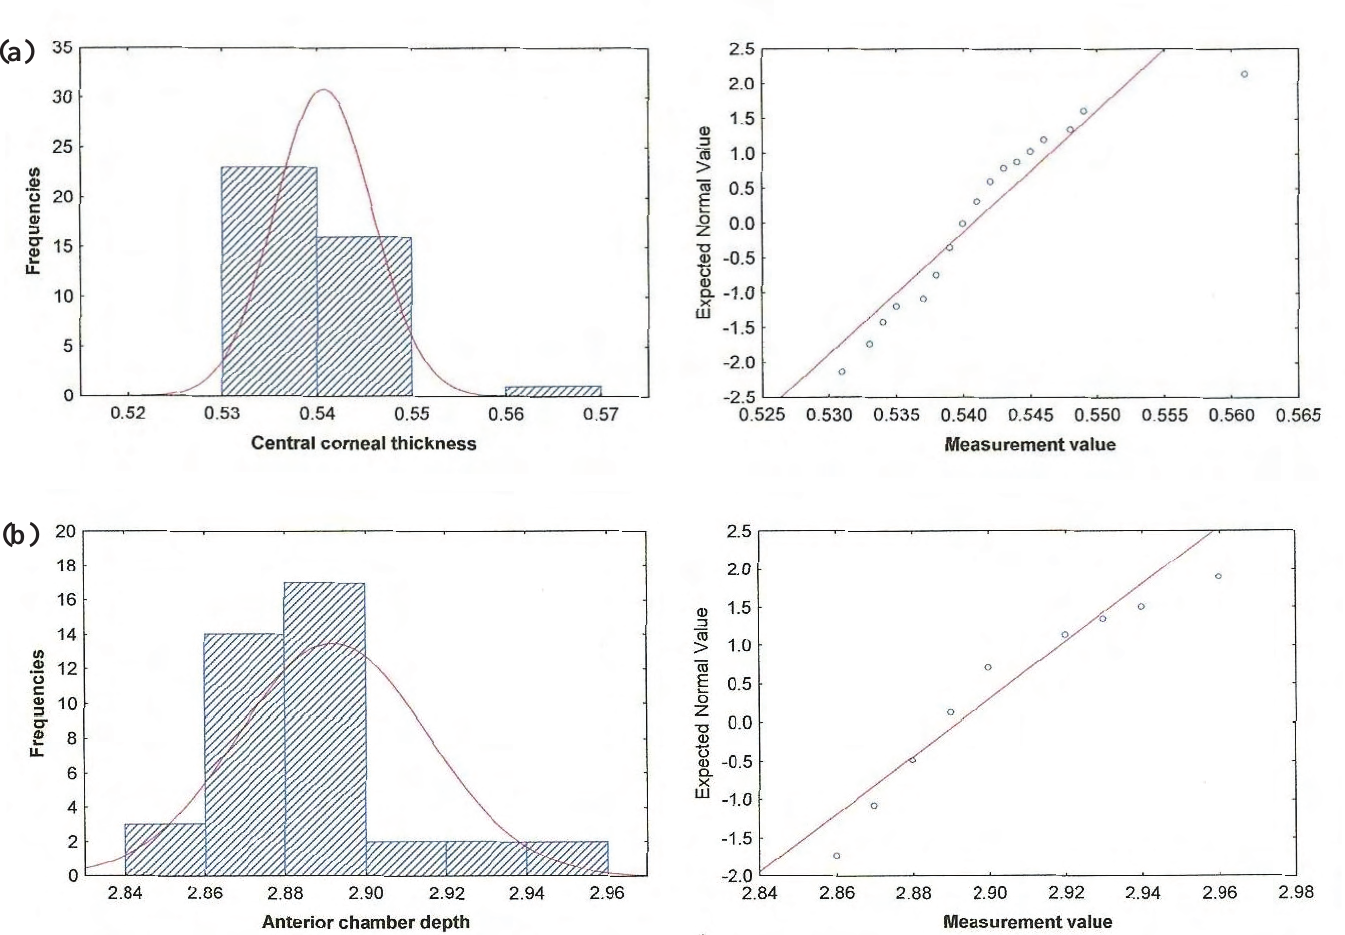
Figure 8. Histogram and normal probability plots for the CCT (a) and AACD (b) samples of subject 2. The samples were not nor- mally distributed according to the p -values for the K-S and Lilliefors tests. For the SW-W tests, p = 0.0006 for (a) and 0.0002 for (b) . Probabilities were less than 0.05 ( p <0.05 suggests rejection of the null hypothesis that the sample is from a normally distributed population). Tables 1 and 2 indicated profound positive skewing and leptokurtosis for both samples, that is, CCT and